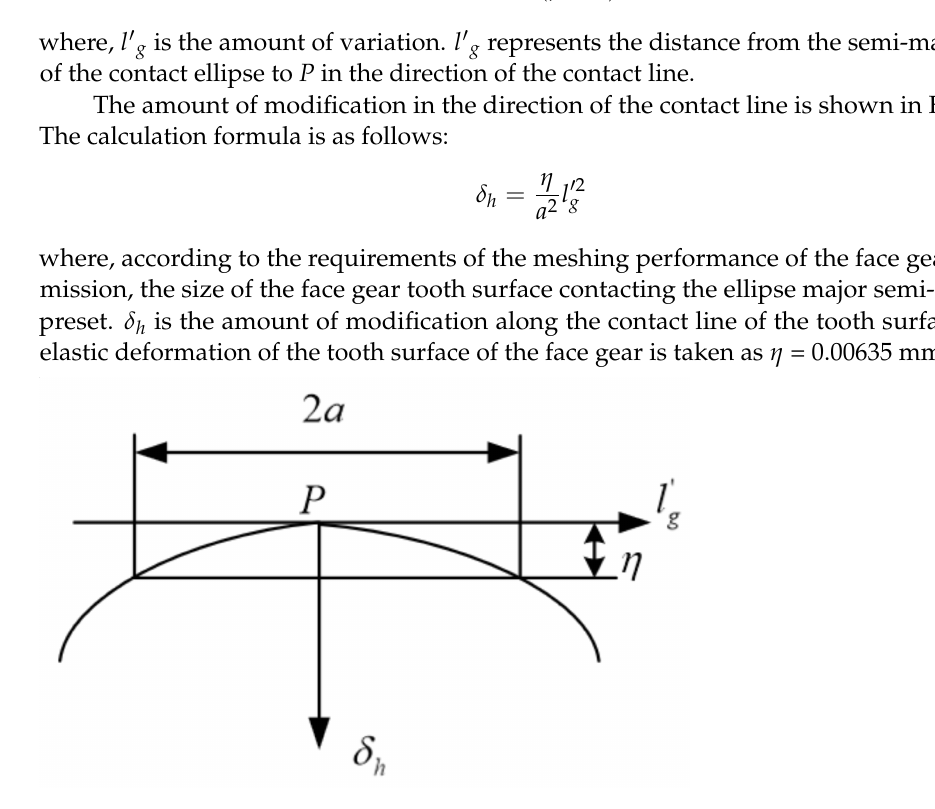
Figure 7. Modification curve in the direction of the contact